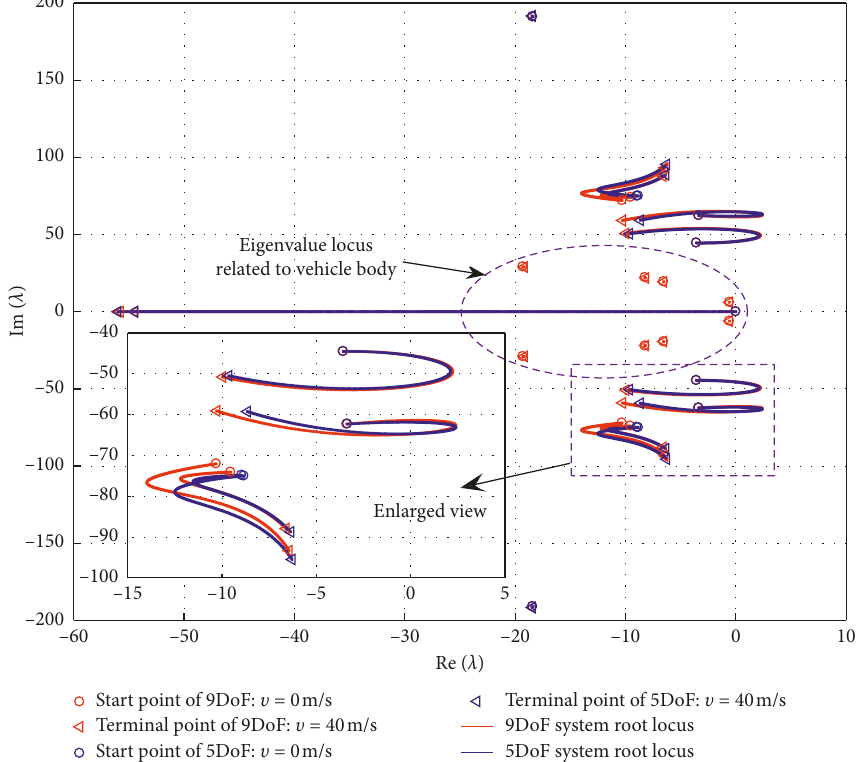
Figure 3: Eigenvalue loci of 9-DoF shimmy and 5-DoF